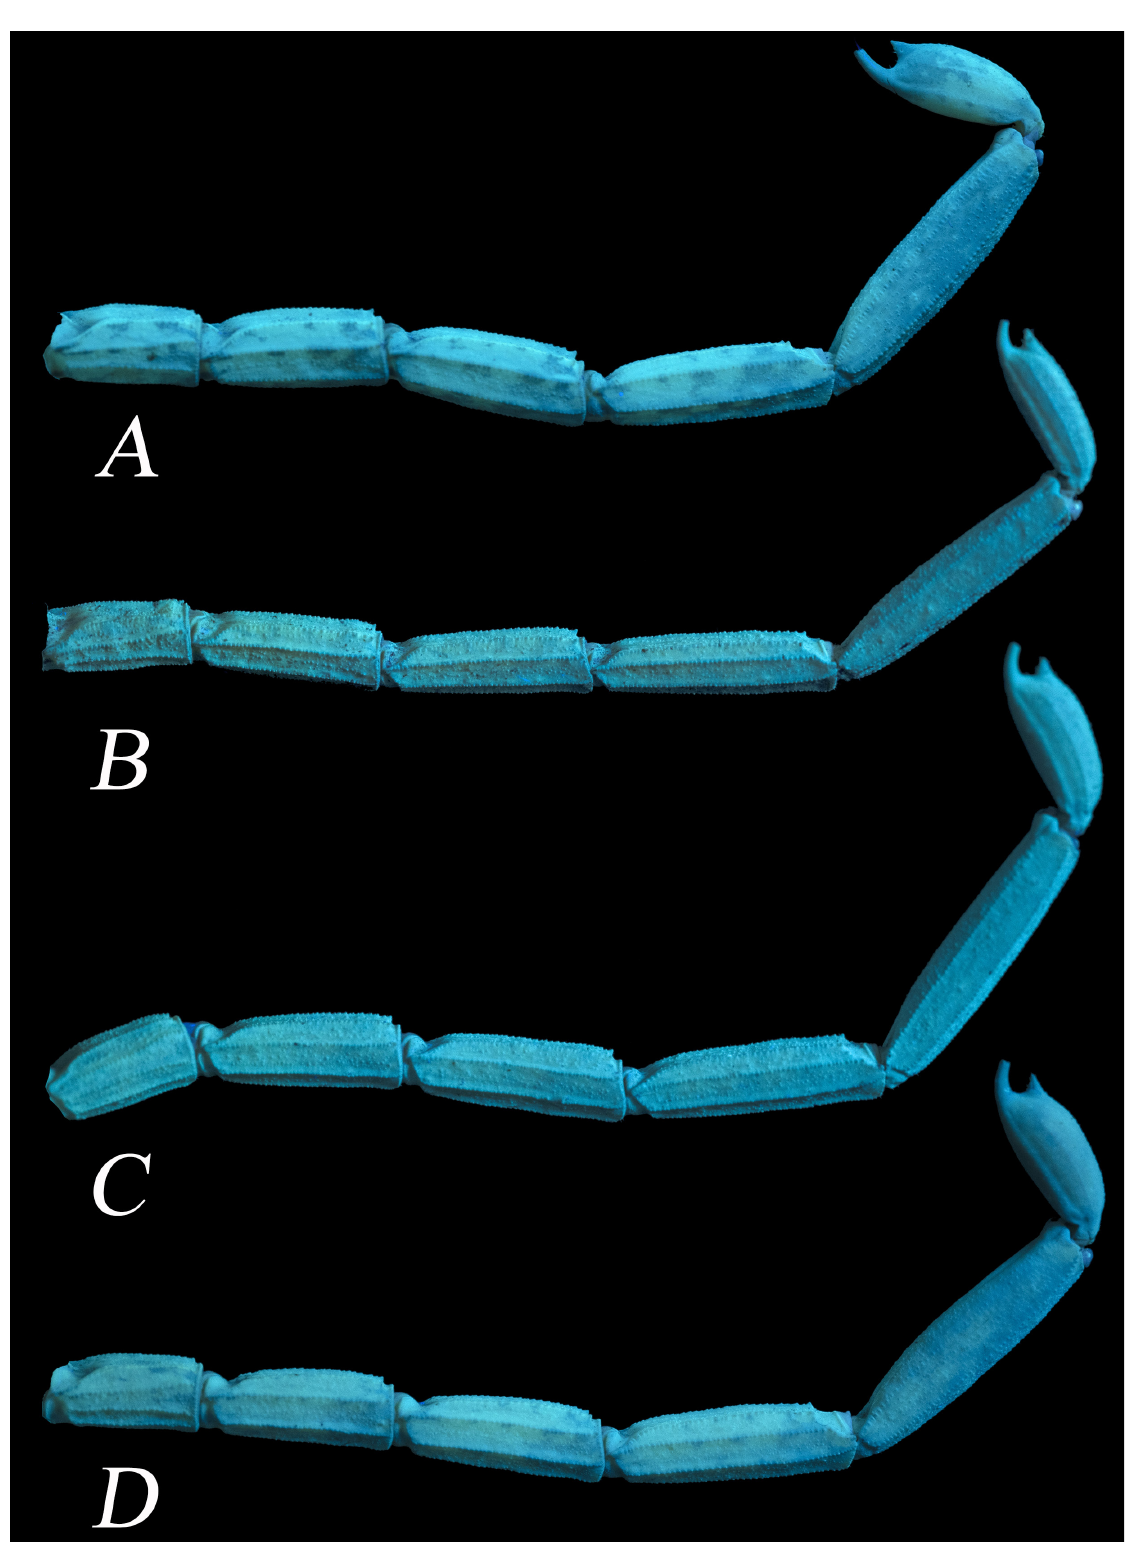
Fig. 22. Metasoma in lateral view under UV light. A . Isometrus thurstoni Pocock, 1983, topotype, adult ♂ (INHER 139). B . I. tamhini Sulakhe et al ., 2020, holotype, adult ♂ (BNHS SC 155). C . I. amboli Sulakhe et al ., 2020, holotype, adult ♂ (BNHS SC 157). D . I. kovariki Sulakhe et al ., 2020, holotype, adult ♂ (BNHS SC